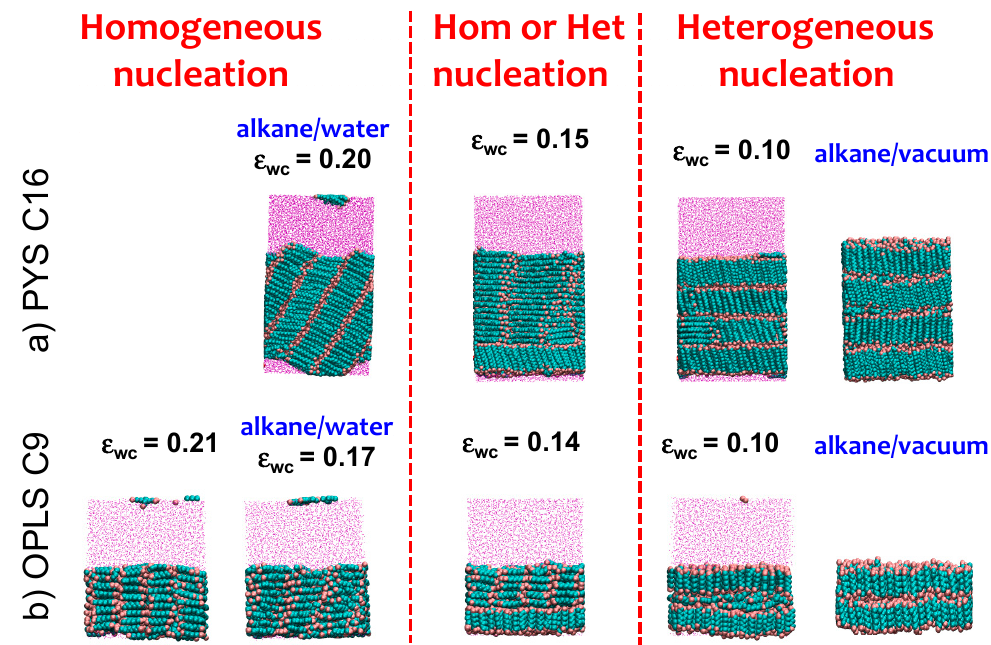
Figure 5. Interfacial orientation of ( a ) PYS hexadecane or ( b ) OPLS nonane crystallized in the presence of solvent (water or vacuum) is reversed from parallel to perpendicular by decreasing the strength of water–carbon interaction ε wc . The trend does not depend on the alkane length or force field. Snapshots shown correspond to the end of the alkane crystallization in the presence of solvent with coupling ε wc indicated. We highlight with blue labels the cells corresponding to the alkane/water parameters that reproduce the experimental surface tension and the alkane/vacuum systems. The change in interfacial orientation from parallel to perpendicular in the crystal coincides with the change from homogeneous to heterogeneous nucleation, and occurs for the neutral ε wc , for which the orientation of the alkanes at the surface of the liquid is the same as in the bulk.